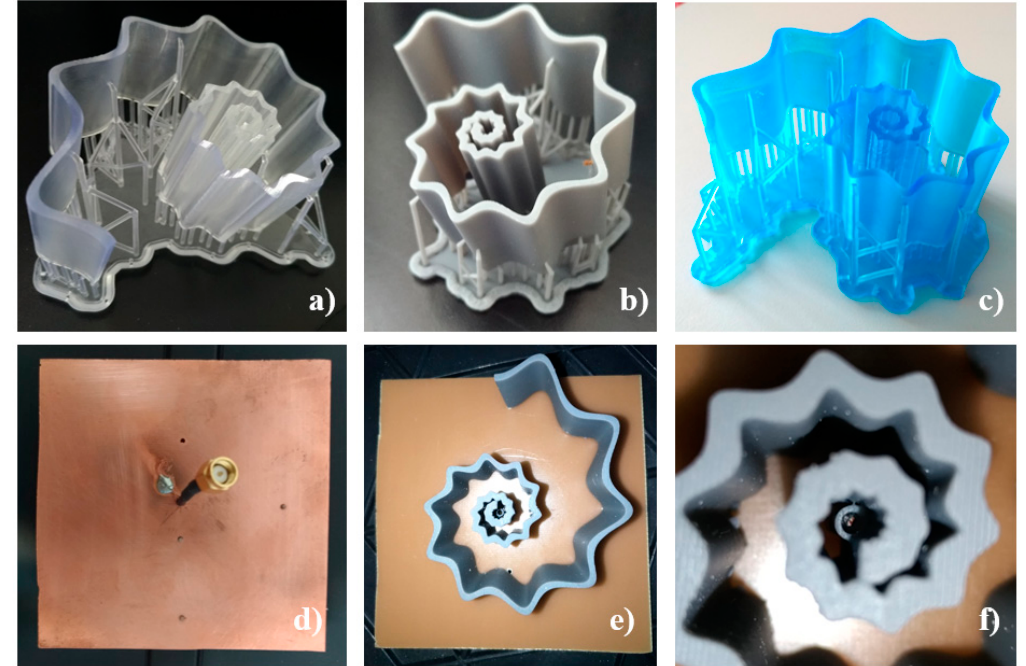
Figure 5. SsDRA prototypes: ( a ) Clear V04 resin SsDRA (DRA1); ( b ) Grey V04 resin SsDRA (DRA2); ( c ) Tough blue V05 resin SsDRA (DRA3); ( d ) Coaxial cable, SMA connector, and pins on the ground plane; ( e ) Top view of the assembled SsDRA prototype; ( f ) Detailed view of the SsDRA’s origin with feed